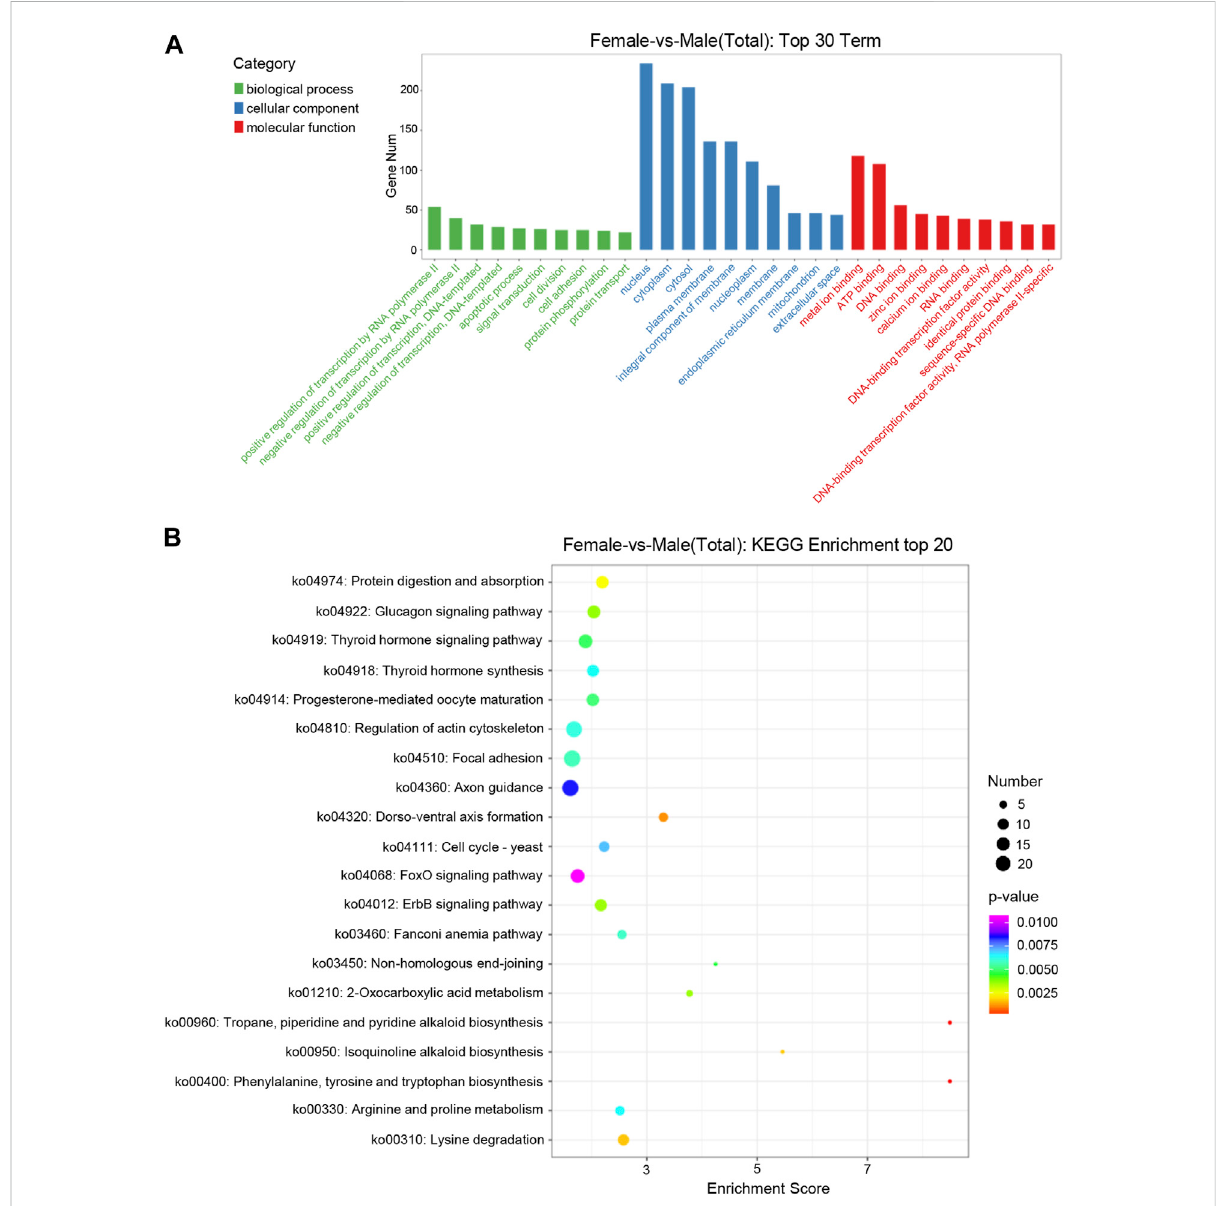
FIGURE 3 Distribution of DE miRNAs. (A) Distribution of DE miRNAs among the top 30 GO terms. The GO terms are related to sex determination. The X -axis represents the name of GO terms. The Y -axis represents the number of genes enriched in each GO term. (B) The fi gure shows the top 20 enriched pathways between the ovary and testis. The X -axis represents the enrichment score. The Y -axis represents the KEGG pathway